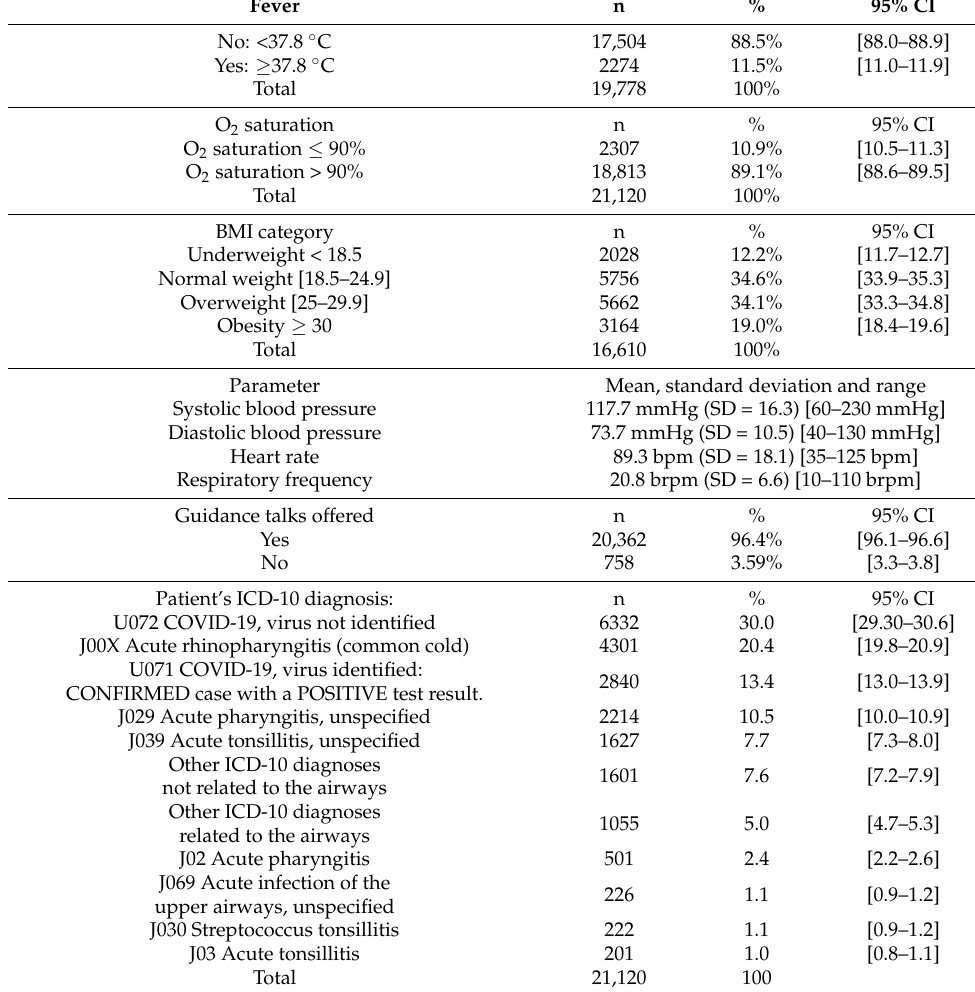
Table 1. Descriptive analysis of the clinical and care